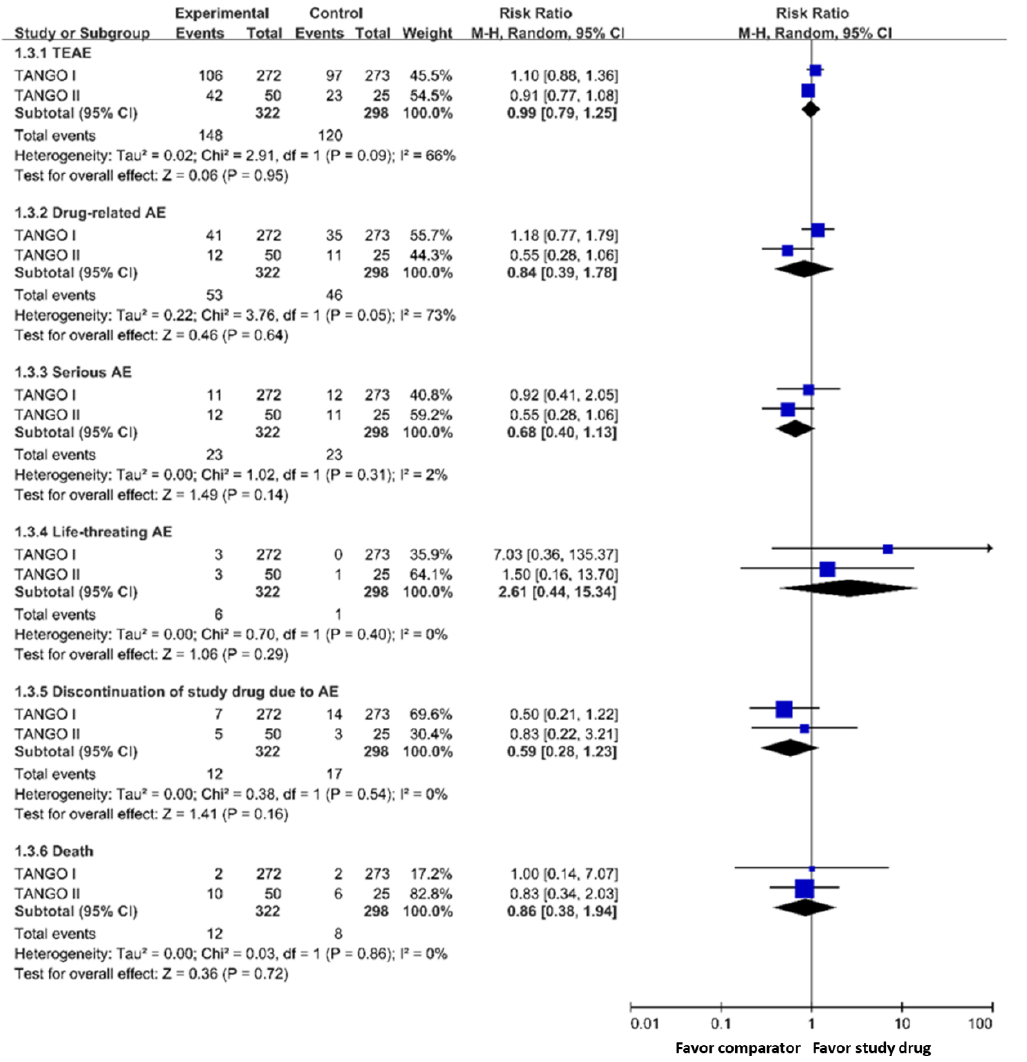
Figure 2. Risk of adverse events of meropenem-vaborbactam and comparators in modified intention-to-treat population analysis. Legend: TEAE, treatment-emergent adverse event; AE, adverse event.